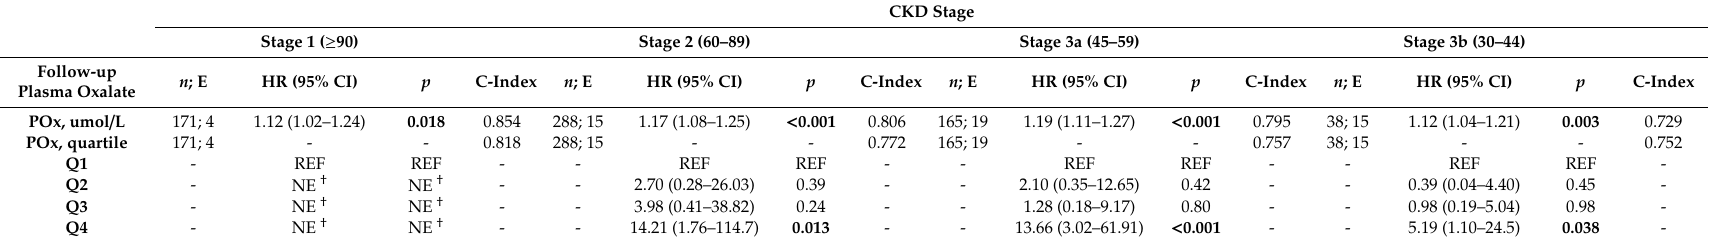
Table 4. Plasma oxalate excretion on follow-up ( > 6 months after entry into the CKD group) and risk of